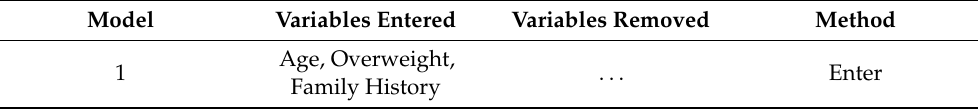
Table 10. Multilinear Regression results of female samples/Variables Entered/Removed. Model